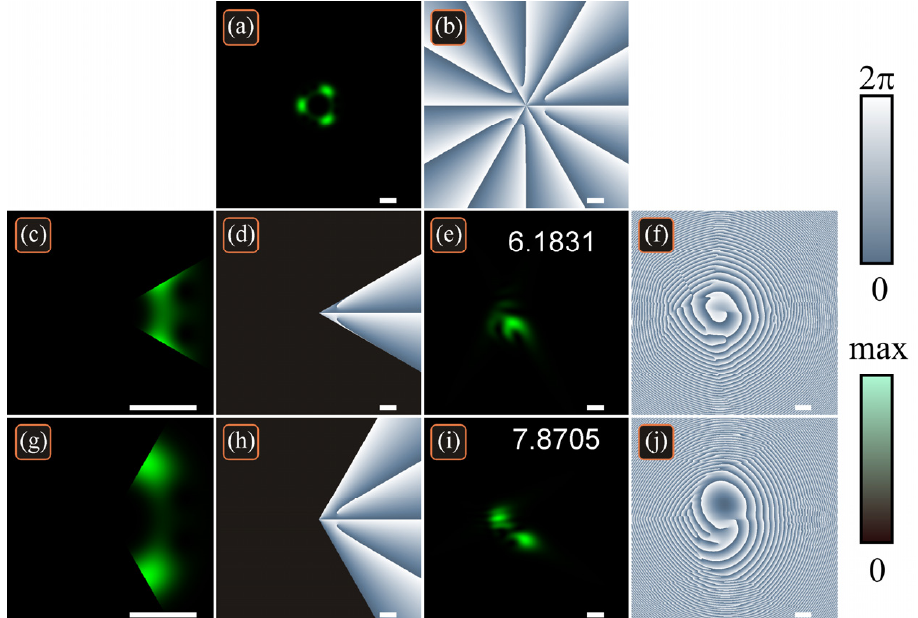
Figure 6. Intensity ( a , c , e , g , i ) and phase ( b , d , f , h , j ) patterns of a superposition of three single-ringed LG beams with different energies before the sector aperture ( a , b ), after two sector apertures with half-angle α = π /6 ( c , d ) and α = π /3 ( g , h ) and after propagation in space over the Rayleigh distance ( e , f , i , j ). Scale mark in each figure shows 1 mm. The text ( e , i ) shows the computed OAM value. The theoretical value of the initial beam is J z / W = 8. The OAM values computed by Equations (1) and (2) confirm that the aperture with α = π /6 distorts the OAM ( J z / W ≈ 6.18), whereas the aperture with α = π /3 leaves the OAM almost unchanged ( J z / W ≈ 7.87).